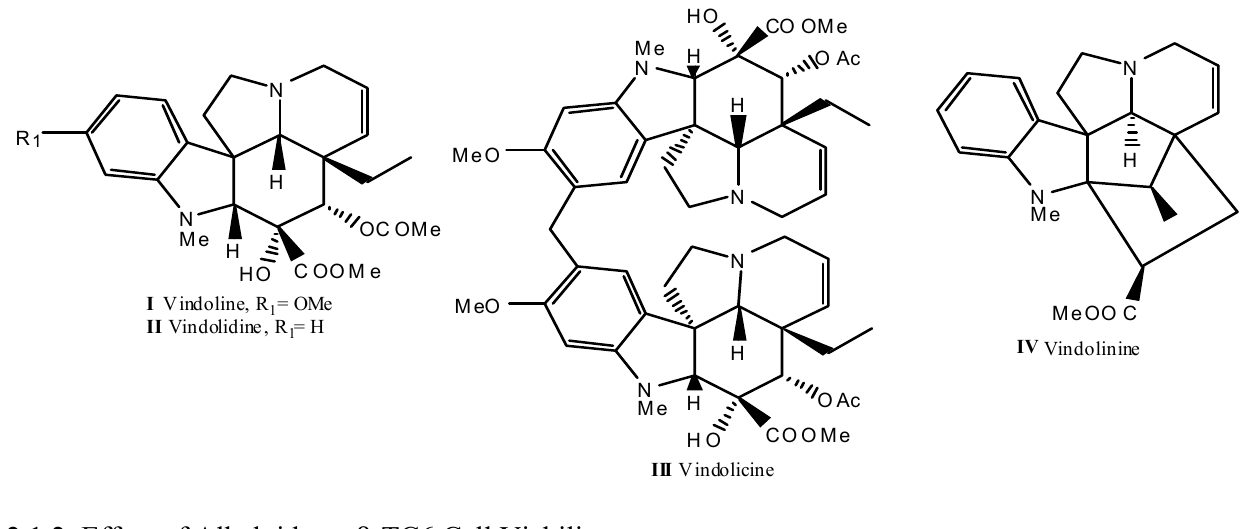
Figure 1. Chemical structures alkaloids I – IV isolated from leaves of Catharanthus roseus .